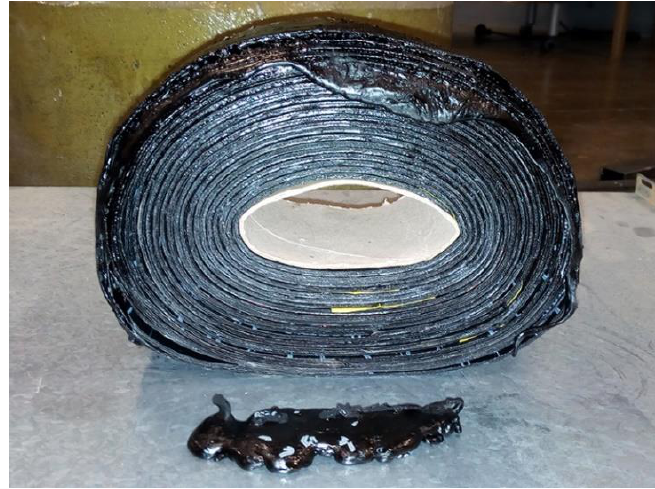
Figure 18. Heated asphalt roll after 8 min of heating.